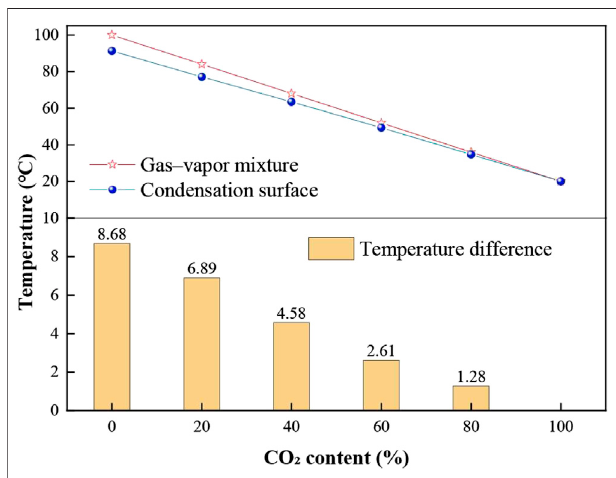
FIGURE 13 | The gas-steam mixture temperature with different CO 2 contents and the temperature of the condensation surface after reaching a steady